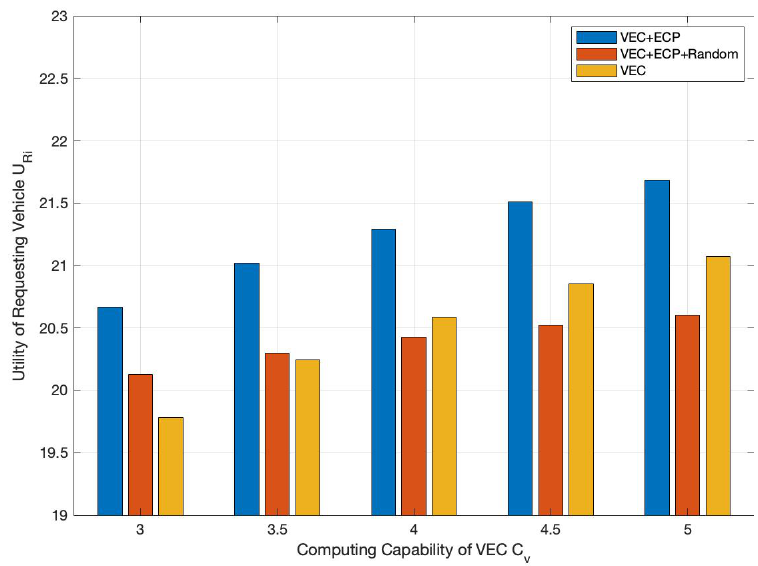
Figure 6. Impact of C v on the utility of requesting